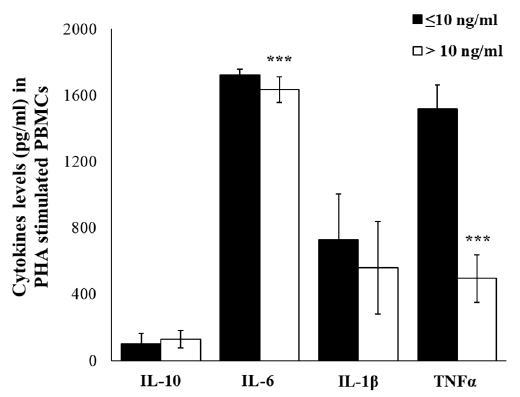
Figure 6. PHA-induced cytokine production. IL-10, IL-6, IL-1 β , and TNF α levels in supernatants of PHA-treated PBMCs of enrolled workers with salivary cortisol levels ≤ or > of 10 ng / mL. Data are reported as mean ± S.D. *** p -value ≤ 0.001.